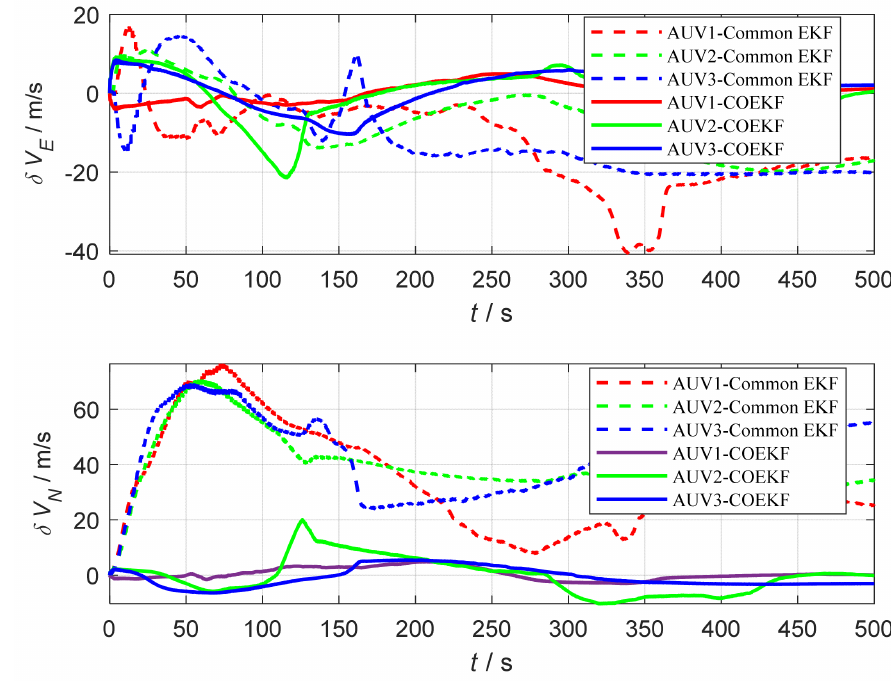
Figure 9. Velocity error comparison